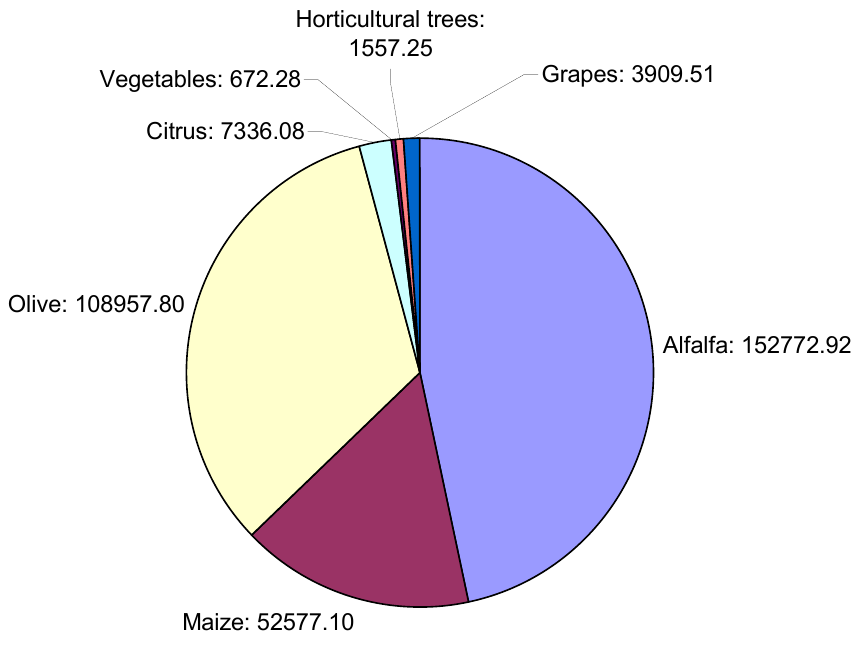
Figure 8. Water volume (m 3 yr -1 ) that is required per crop in Nafpaktos area.